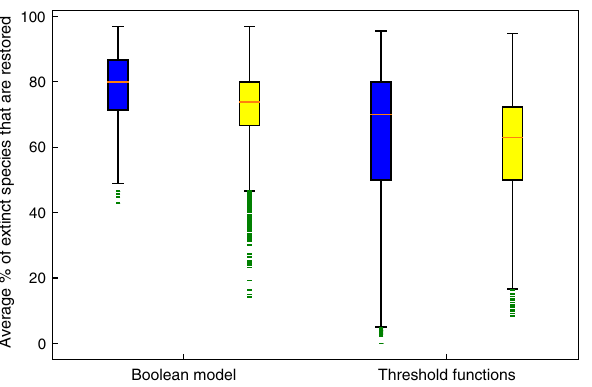
Figure 10. Box and whiskers plots illustrating the average percentage of the extinct species that are restored following the stable motif driver set restoration strategy (blue) versus the functional diversity based approach (yellow). This analysis is performed over 6000 networks with sizes of 50–70 nodes. Starting from the maximal richness community, for each network one inactive stable motif with a driver set of 1, 2 or 3 nodes was stabilized to reach a new damaged community. This task was performed until the community with the most extinct species was identified. This is the community we set as the starting point for the restoration process using both methods. The pair on the left represents the two methods applied to the simplified Boolean model. For both methods we identified 1, 2, or 3 influential nodes for community restoration and we calculated the percentage of the extinct species that could be restored. The pair on the right represents restoring the same species identified by each method in the previous analysis in the original threshold model. In all analyses the community restoration percentage was averaged over all combinations of the same size, for each network and each method. The IDs of all networks are